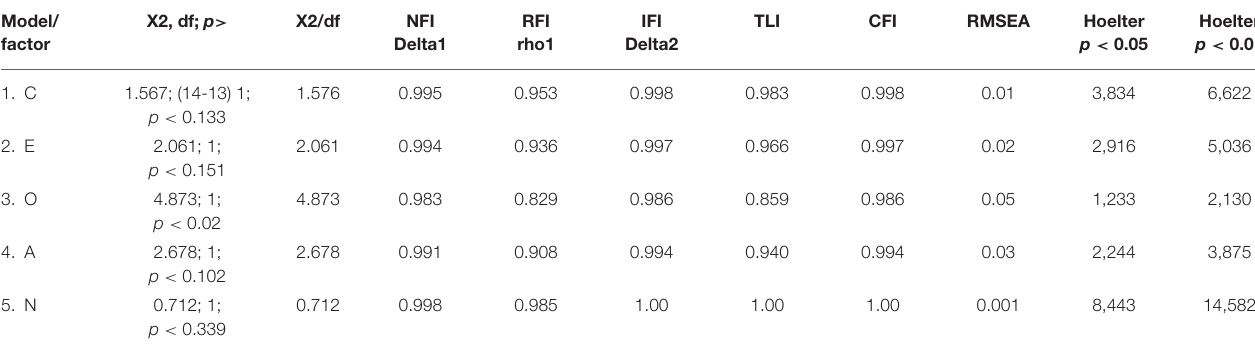
X2, df; p > X2/df NFI